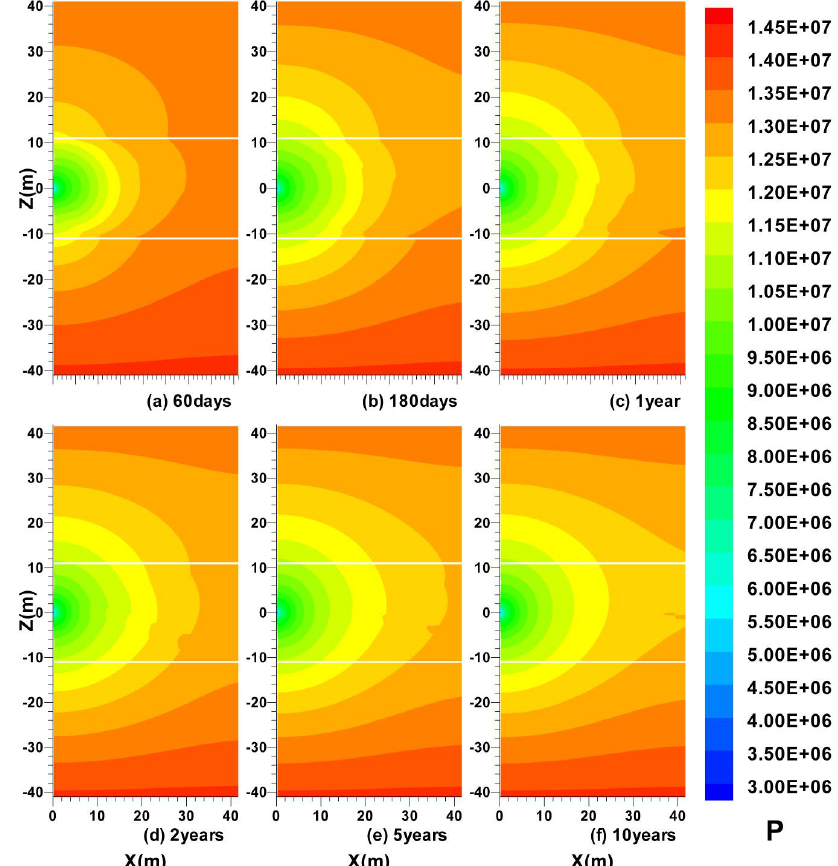
Figure 7. Evolution of spatial distribution of P with permeable boundaries (OB and UB) in Case